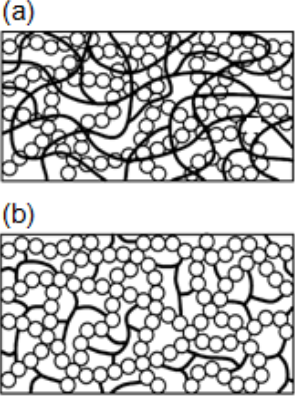
Figure 8. Schematic representation of IPNs ( a ) without chemical bonds between moieties and ( b ) dual hybrid network. Reprinted with permission from [99]. Copyright 2003